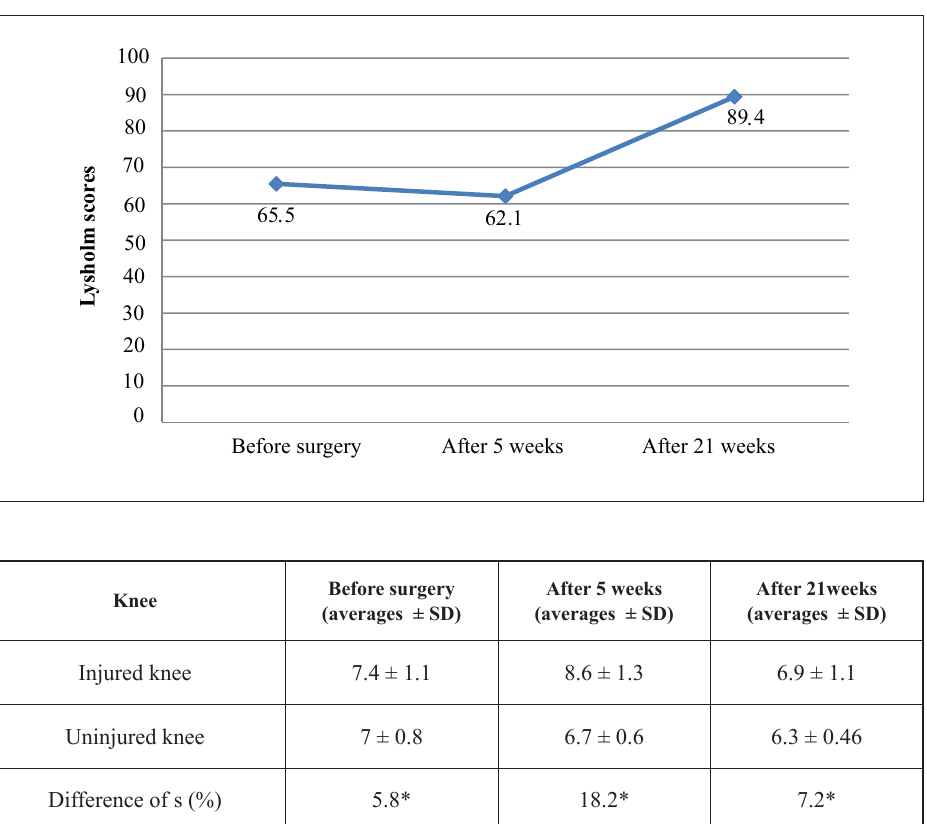
Table 2. Lysholm Knee Functional Scale scores (means, SD, percentage (%) and number of patients with knee functional condition)